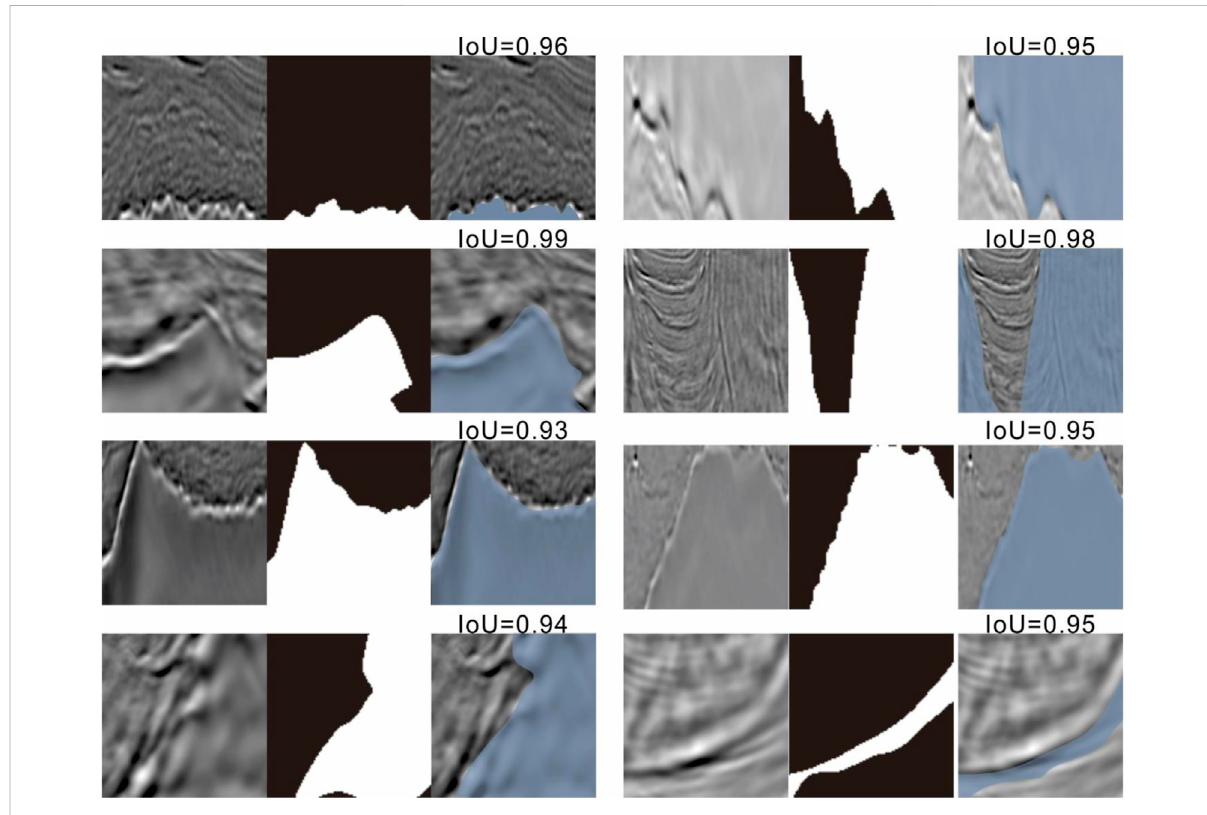
FIGURE 12 ThealgorithmperformanceontheTGSdataset(ineachcell,fromtheleft,midtotheright,aretherawseismicimages,segmentedlabelsandthe predicted images. The predicted salt zone is the blue